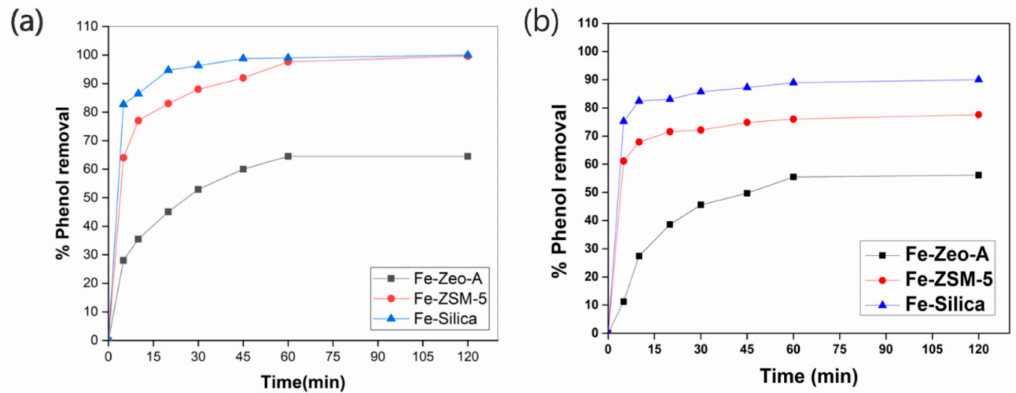
Figure 7. Heterogeneous photo-Fenton degradation of phenol in the ( a ) absence and ( b ) presence of tert-butanol (1.5